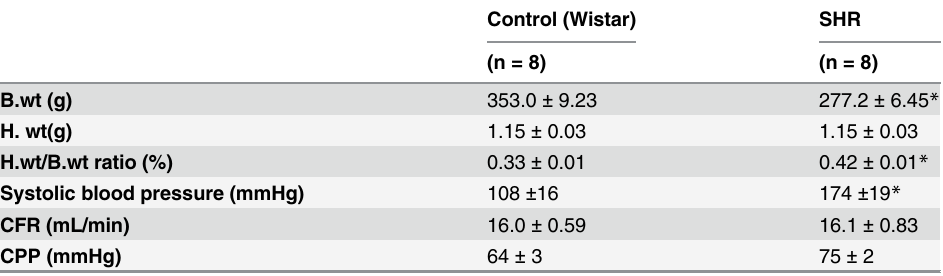
Table 1. Baseline parameters (absence of any antagonist) for control Wistar rats and spontaneously hypertensive rats (SHRs).